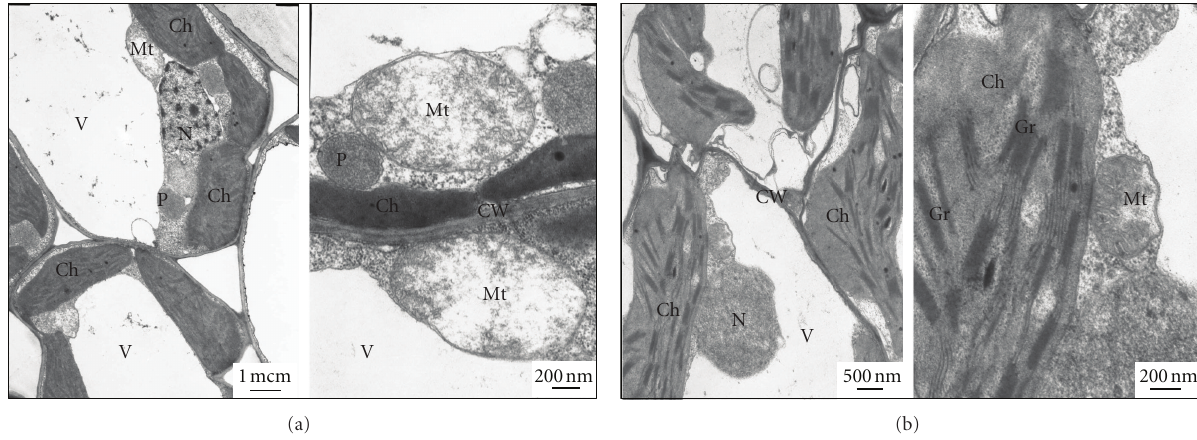
Figure 7: Ultrastructural organization of plant cells ( O. sativa L.) grown in media with (a) and without (b) EMVs of A. laidlawii PG8. V: vacuole, Gr: grana, CW: cell wall, Mt: mitochondria, P: peroxisome, Ch: chloroplast, N: